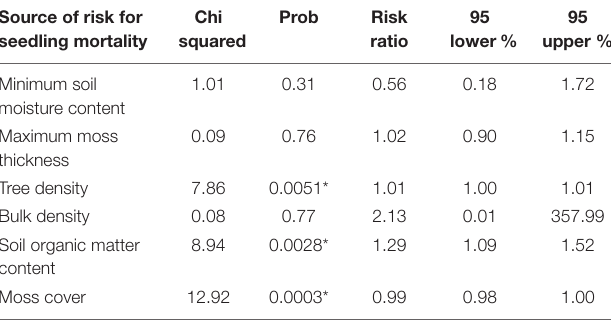
TABLE 3 | Analysis of proportional risks (Cox